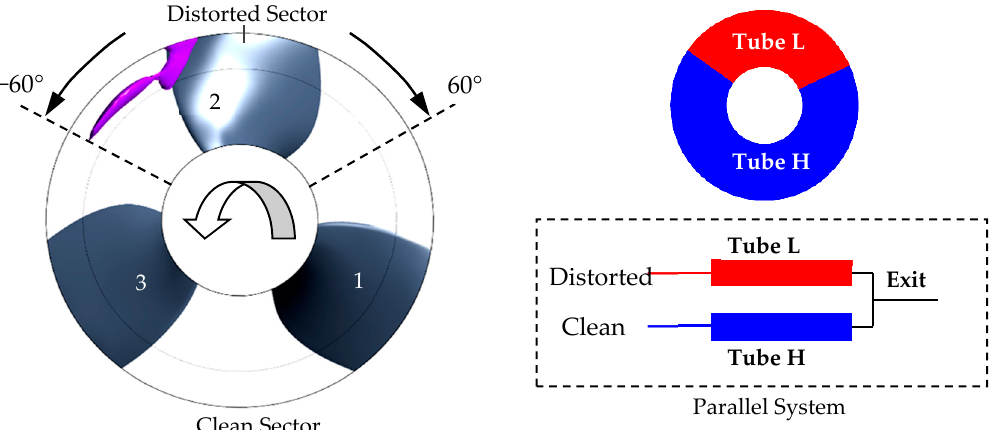
Figure 6. Parallel compressor model in waterjet pump with nonuniform inflow, the contour surface with Q c = 40,000 s − 2 is chosen as the circumferential vortex, colored by purple.